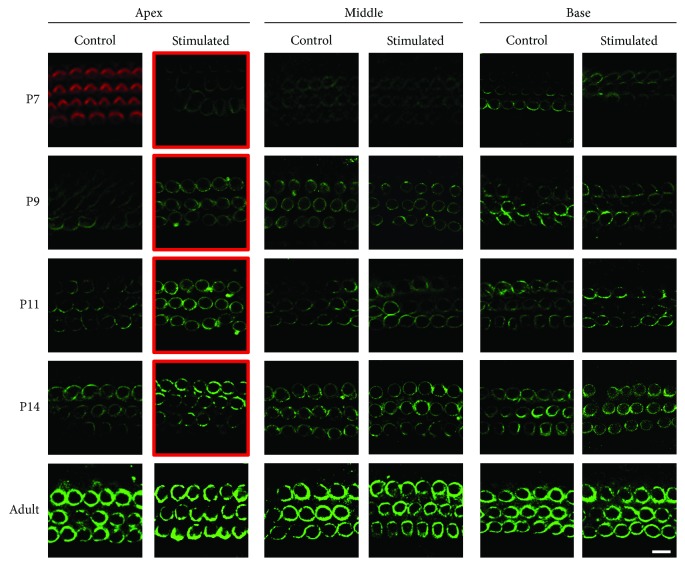
Confocal images indicate that a low-frequency sound environment increases the expression of prestin in apical OHCs during postnatal development. Prestin (green) was labeled in three segments (apex, middle, and base) along the cochlea in P7, P9, P11, P14, and adult mice. For P7 apical turns, no green fluorescence was detected. The hair bundles of hair cells were labeled with rhodamine-phalloidin (red) to indicate the location of the hair cells. The red borders mark the postnatal ages at which prestin expression level was higher in the sound-stimulated group. Scale bar = 10 μm. OHC: outer hair cell; P: postnatal day.